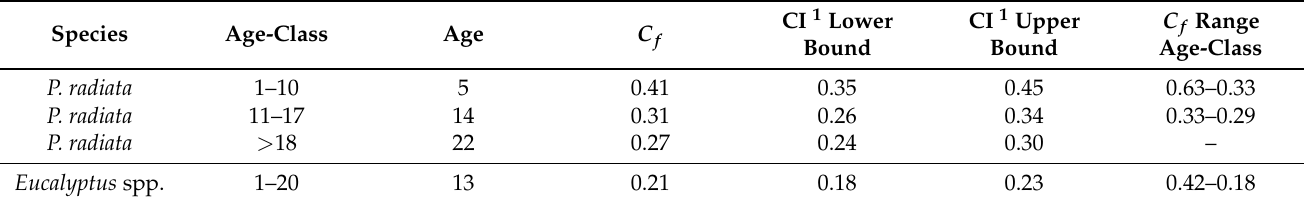
Table 5. C f values’ aggregates to age classes used in